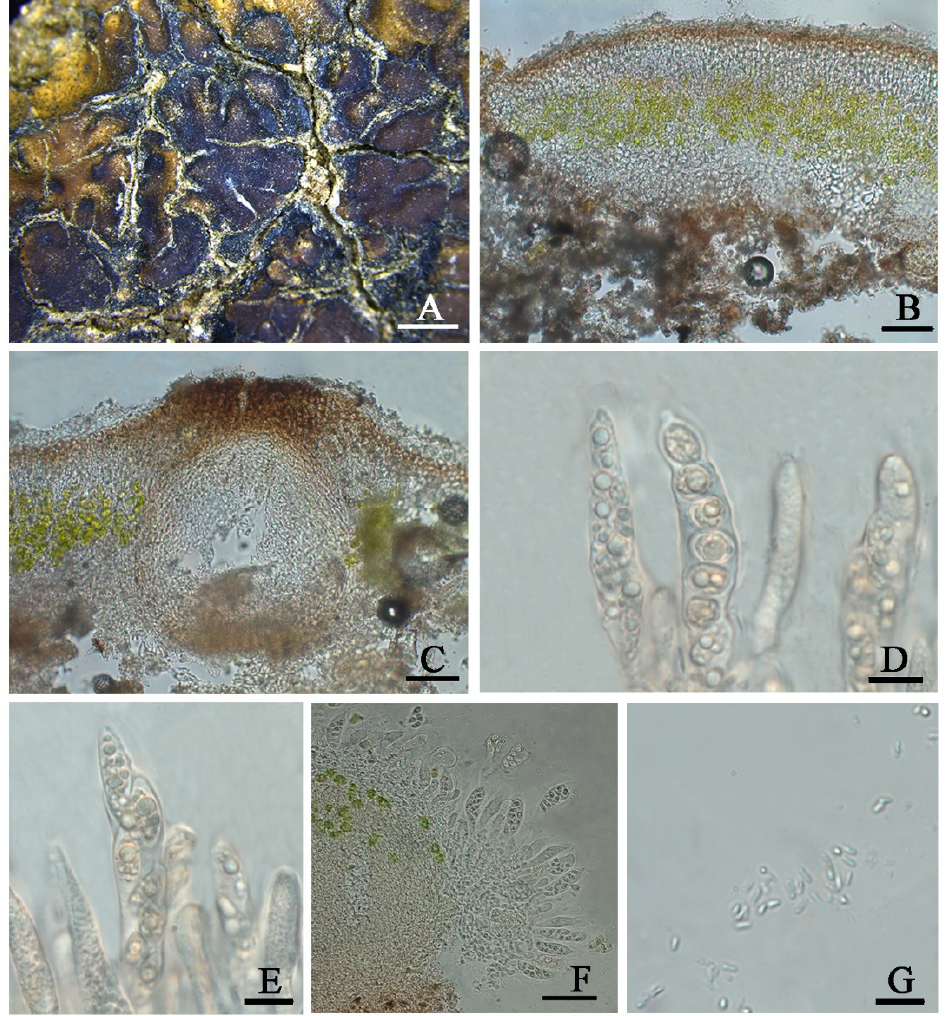
Figure 3. The thallus habit and the anatomic structure of Clavascidium lacinulatum (HMAS-L 153962). ( A ). Squamulose thallus. ( B ). Transversal section of thallus. ( C ). Immersed perithecium. ( D , E ). Uniseriate ascospores in cylindrical asci. ( F ). Biseriate ascospores in clavate asci. ( G ). Conidia. Bars: ( A ) =2 mm, ( B , C ) =50 µm, ( D , E ) =10 µm, ( F ) =50 µm, and ( G ) =10 µm. Clavascidium sinense T.T. Zhang & X.L. Wei, sp. nov. (Figure 4)